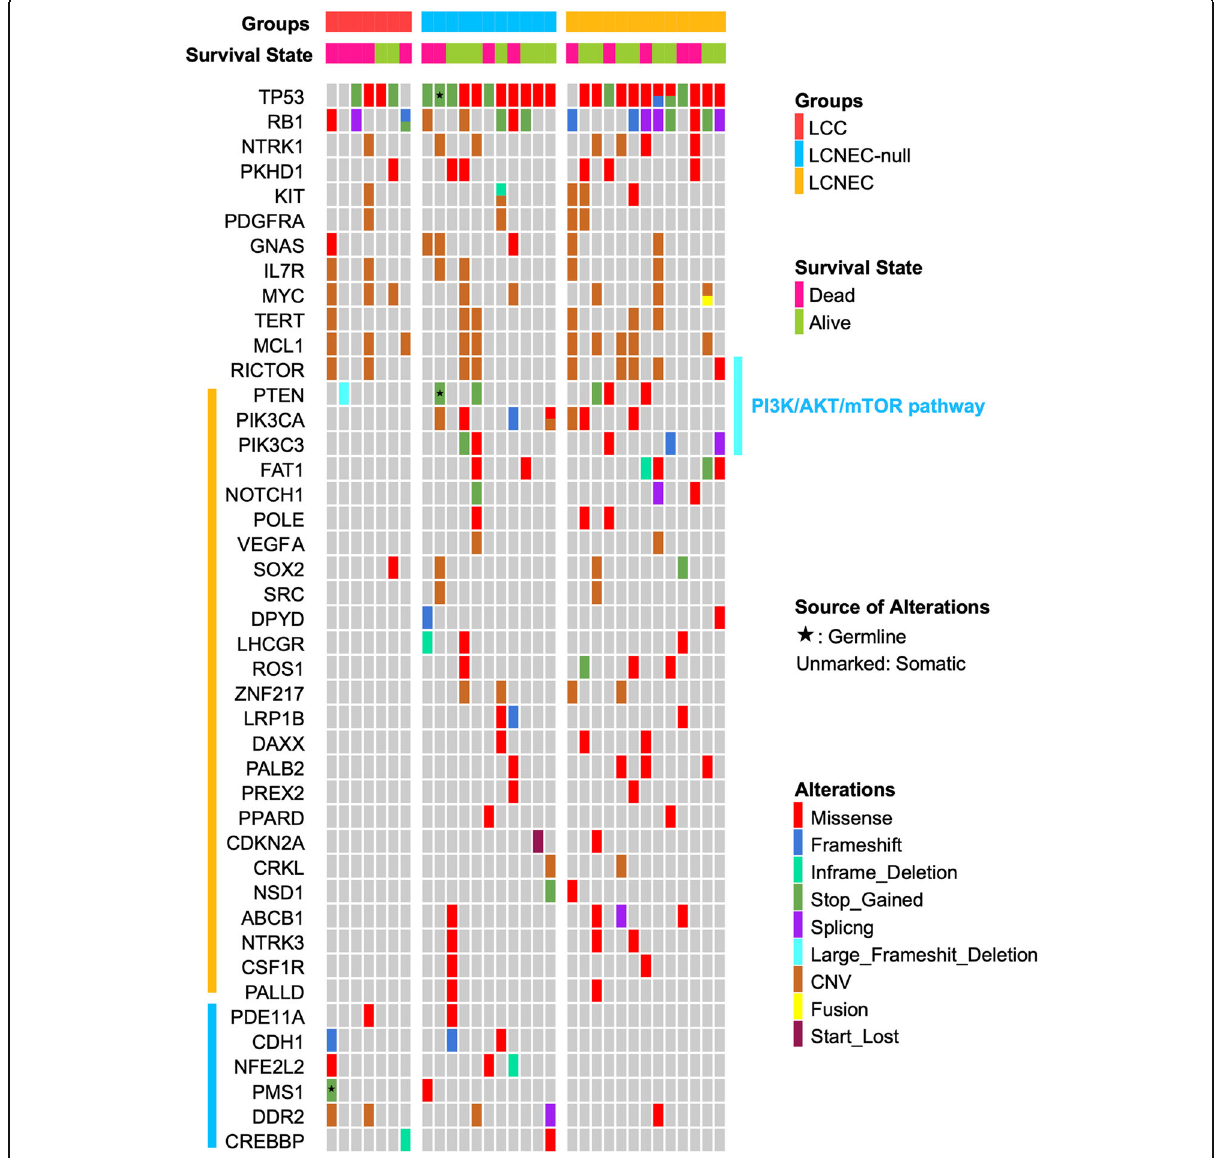
Fig. 3 Comparison of clinicopathology and molecular alteration among LCCs, LCNEC-nulls and LCNECs. Molecular alterations we present are based on LCNEC-null. Among 43 genetic alterations detected, the first 12 mutations were shared by three groups, 25 mutations of LCNEC-nulls are similar with LCNECs (marked with orange line), and only 6 are similar with LCCs (marked with blue